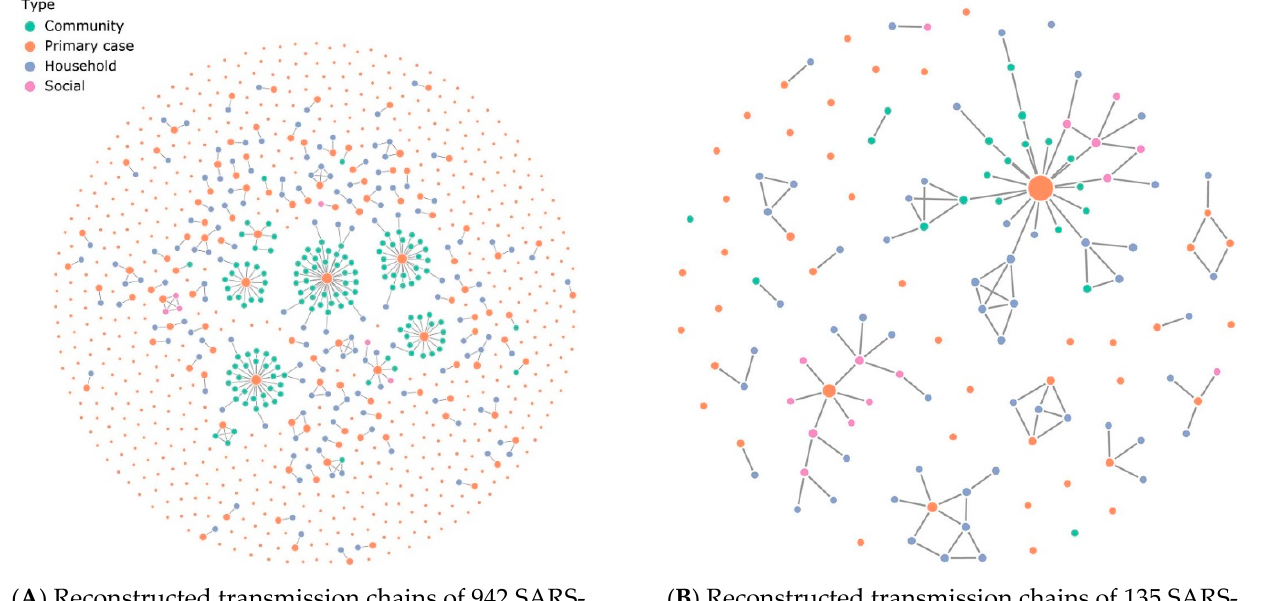
Figure 1. SARS-CoV-2 transmission chains. Each node in the network represents a patient infected with SARS-CoV-2, and each link represents an infector–infectee relationship. The color of the node denotes the reporting contact type of the infected individuals. The size of the node corresponds to the number of secondary cases.